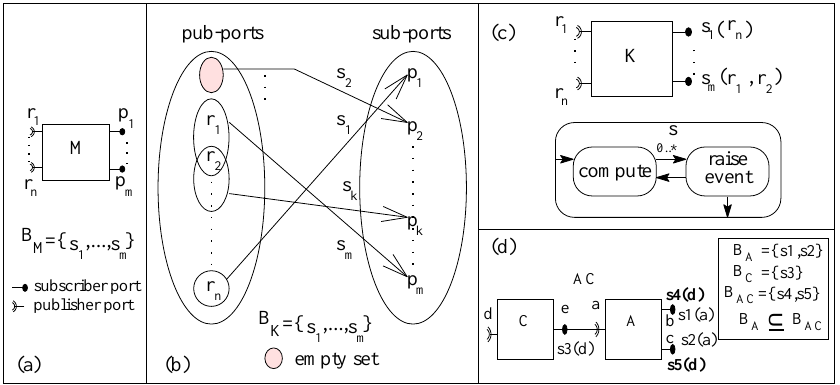
Figure 17. ( a ) A component, ( b ) Port relations, ( c ) Execution semantics, and ( d ) A composite.